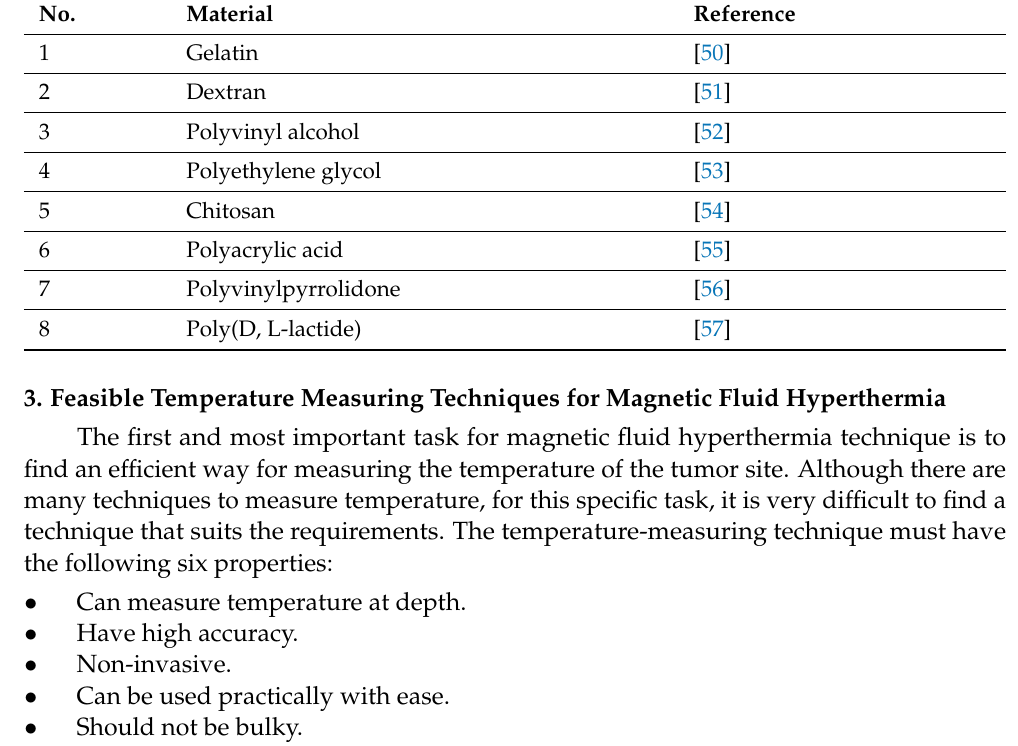
Table 1. Different materials used for coating of nanoparticles.